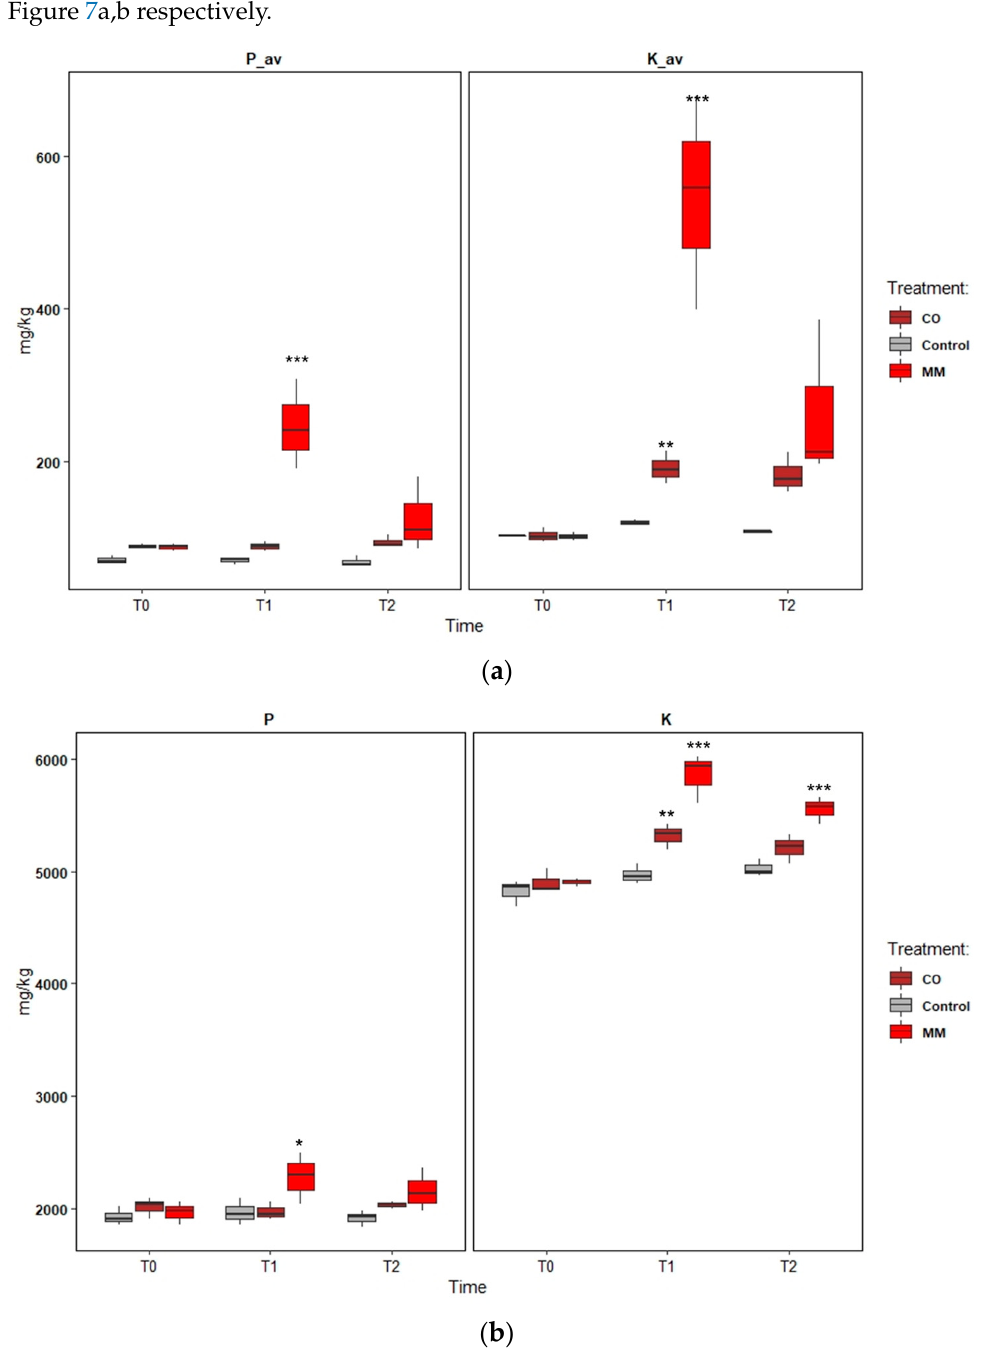
Figure 7. ( a ) Available P (P_av) and exchangeable K (K_av) and ( b ) total P (P) and total K (K) fractions dynamics in the first year after amendment application (from T0 to T2) in one experimental field (D1), comparing soil amended with compost from digestate (CO), soil amended with matured manure (MM), and soil without amendment application (Control). The significantly different means per sampling date (T0–T2) are identified through asterisks; *** = p > 0.001; ** = p > 0.01; * = p >